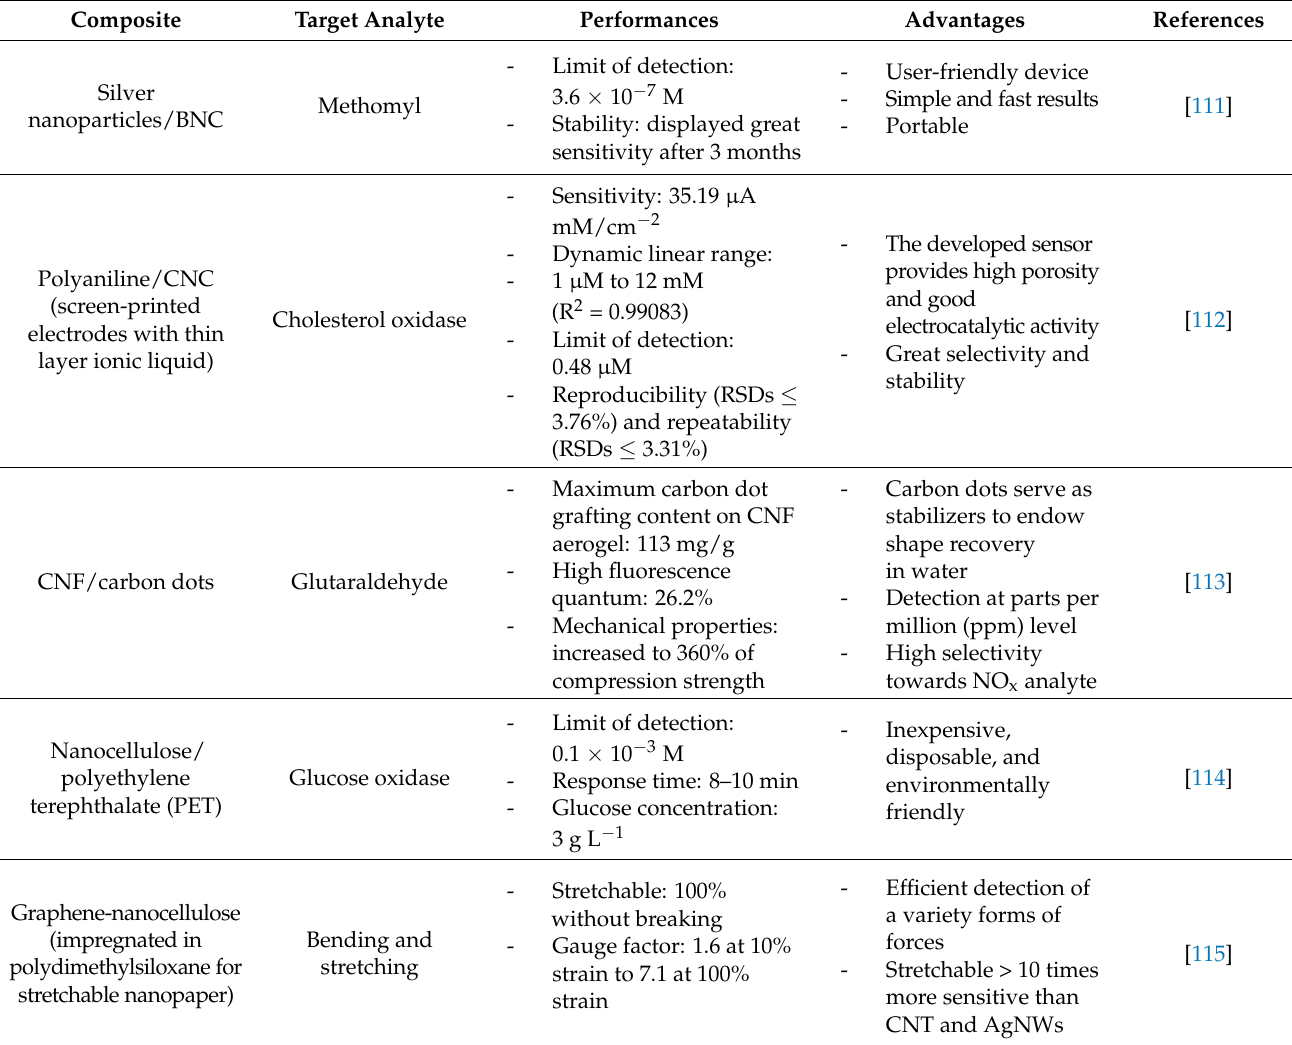
Table 4. Performance of nanocellulose composite chemical